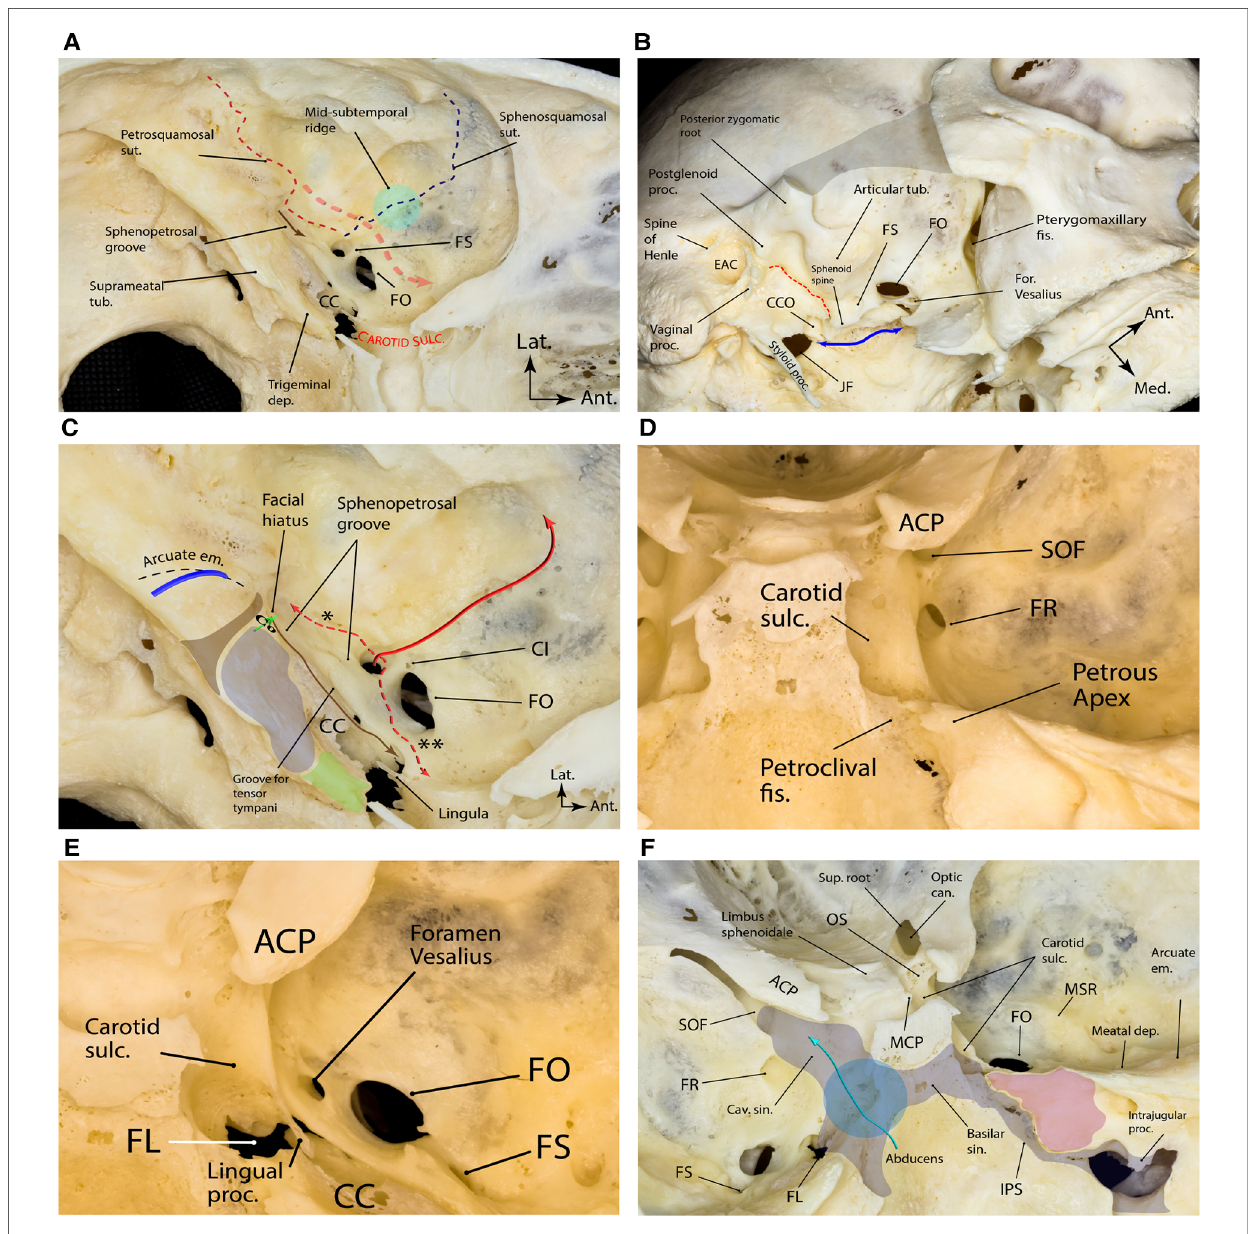
FIGURE 4 Bony landmarks of the middle fossa proper. ( A ) Note the two major bony sutures emanating from the lateral aspect of the foramen spinosum that harbors the lateral triangle of the middle cranial fossa, which is the corridor to exposing the pterygoid portion of the internal maxillary artery (red dashed arrow). The sphenopetrosal groove (brown arrow) is the pathway for the greater super fi cial petrosal nerve. ( B ) Oblique inferior view of the exocranial surface of the middle cranial fossa. The gray shaded area shows the resected zygomatic arch. The blue double arrow marks the exocranial petroclival fi ssure ending posteriorly in the jugular foramen. The sphenoid spine is found just medial to the foramen spinosum and is the point of attachment of the sphenomandibular ligament. The dashed red line marks the petrotympanic (Glaserian) fi ssure through which the chorda tympani nerve passes to join the lingual nerve. ( C ) Bony anatomy of the petrous apex. The brown shaded area shows the projection of the funnel-shaped internal auditory canal as the posterior boundary of the middle fossa rhomboid (stone blue shaded area) and the true petrous apex (green shaded area). Posterior to the internal auditory canal, one could fi nd the arcuate eminence, which approximates the underlying superior semicircular canal (blue arch). Cochlea (Co) lies just anterior to the fundus of the internal auditory canal (green arrow showing the trajectory of the modulus axis). Tensor tympani muscle (brown arrow) lines the superomedial aspect of the osseous portion of the pharyngotympanic tube. The middle meningeal artery (solid red arrow) enters the skull through foramen spinosum and gives two important branches (dashed red arrows); the petrous branch (*) is the posterior, and the cavernous branch (**) is the anterior branch. ( D ) Posterior view of right middle fossa showing the relationship of the foramen rotundum with adjacent bony landmarks. ( E ) Superior view of right middle fossa showing the foramen Vesalius anteromedial to the foramen ovale. ( F ) Magni fi ed endocranial view of the petrous face and its relationship with middle fossa and sellar bony anatomy. Note the relationship between the venous compartments of the posterior and middle fossae around the clivus. Also, note the region of sphenopetroclival venous gulf (blue circle) as a major con fl uence between the basilar, inferior petrosal, superior petrosal, and cavernous sinuses. The purple area is the petrous apex. Ant., anterior; can., canal; CC, carotid canal; CI, canaliculus innominatus; CCO, carotid canal ori fi ce; cav., cavernous; dep., depression; EAC, external auditory canal; em., eminence; fi s., fi ssure; for., foramen; FL, foramen lacerum; FO, foramen ovale; FR, foramen rotundum; FS, foramen spinosum; JF, jugular foramen; IPS, inferior petrosal sinus; Lat., lateral; MCP, middle clinoid process; Med., medial; MSR, midsubtemporal ridge; OS, optic strut; proc., process; sin., sinus; SOF, superior orbital fi ssure; sulc., sulcus; sup., superior; sut., suture; tub., tubercle. (Copyright Ali Tayebi Meybodi. Used with